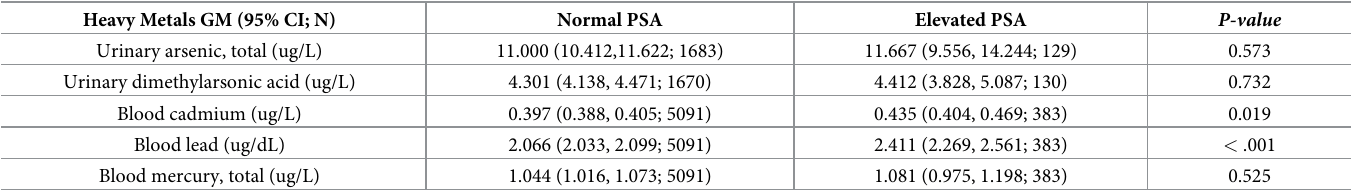
Note: Logistic regression was used to compare geometric means between serum PSA groups in which the p-values were calculated based on t-tests; PSA = prostate- specific antigen; NHANES = National Health and Nutrition Examination Survey; GM = geometric mean; and, CI = confidence